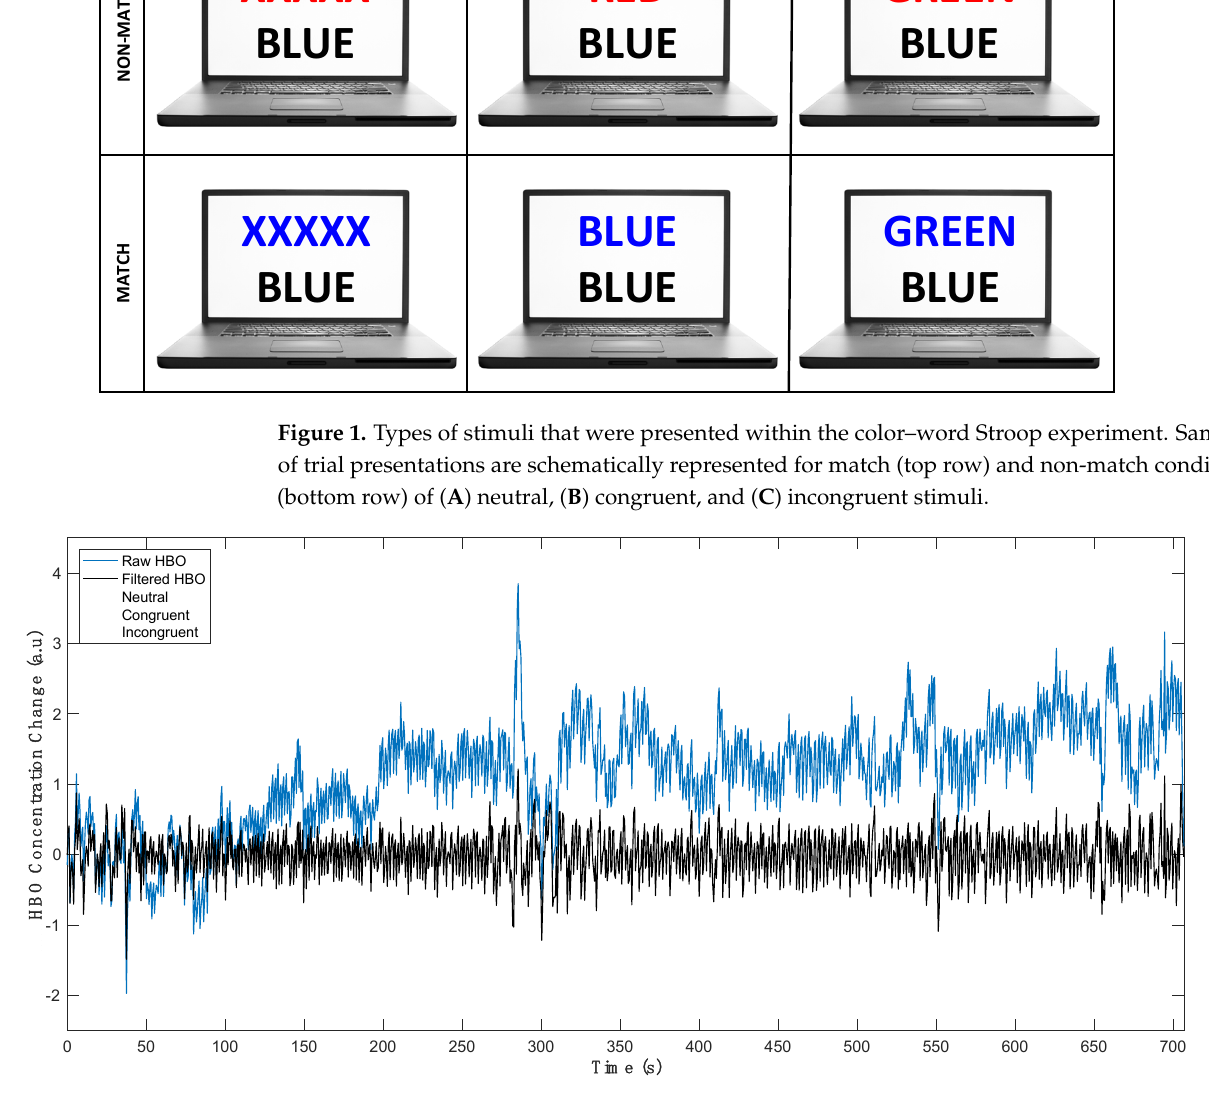
Figure 2. Experimental protocol depicting stimuli timing for neutral, congruent, and incongruent stimuli blocks in a sample session. HBO time series from a representative channel of a subject are plotted before (black) and after an 8th order Butterworth high-pass filter is applied with a cut-off frequency of 0.009 Hz (blue). a.u: arbitrary units.